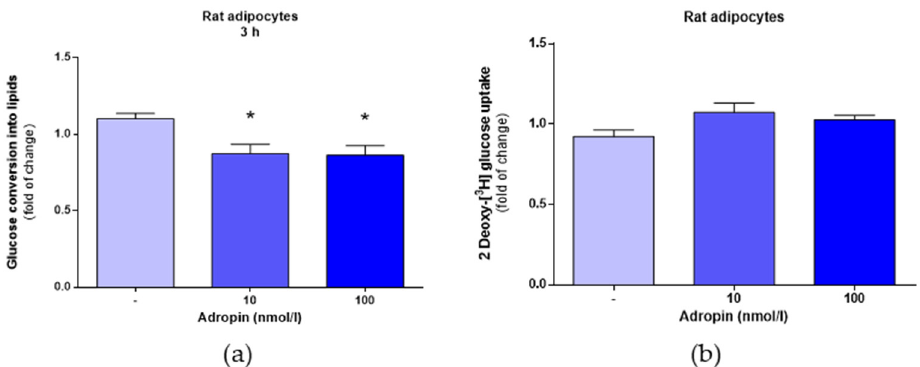
Figure 4. The effects of adropin on lipogenesis and glucose uptake in rat preadipocytes. Incorporation of (C14) glucose into lipids in cells exposed to adropin (10 or 100 nmol/L) or vehicle (sterile distilled water) (-) for 3 h ( a ). Glucose uptake in adipocytes treated with adropin (10 or 100 nmol/L) for 30 min ( b ). Results are the mean ± SEM ( n = 8). p < 0.05 (*).